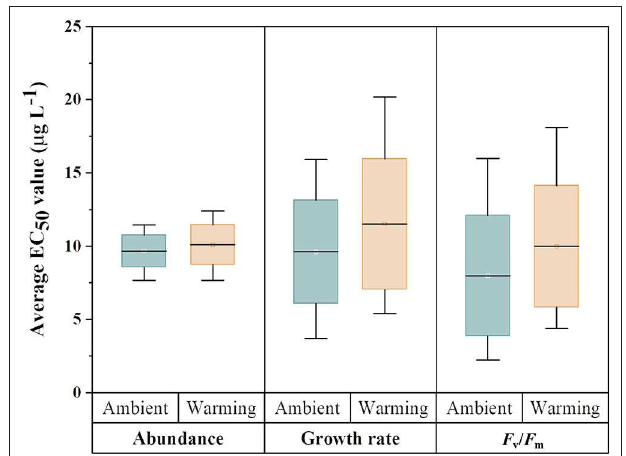
FIGURE 4 | Comparison of the distribution of EC 50 values for various criteria tested across three temperatures for ambient-adapted and warming-adapted Chaetoceros tenuissimus . Tops and bottoms of box plots represent the 75 th and 25 th percentiles, respectively, and black horizontal lines the medians.